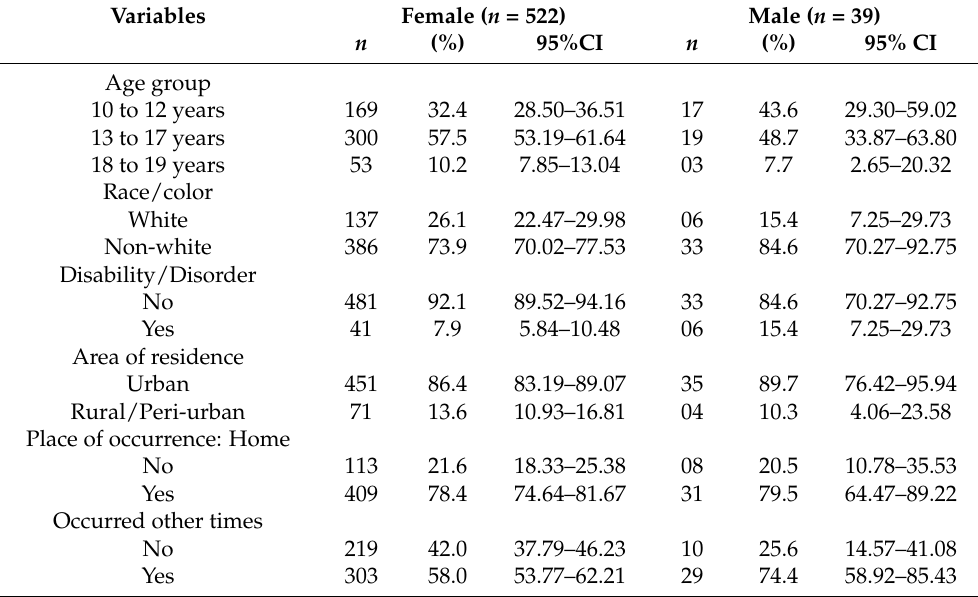
Table 1. Characteristics of reported cases of sexual violence against adolescents aged 10 to 19 years. Esp í rito Santo, Brazil, 2011 to 2018 ( n =